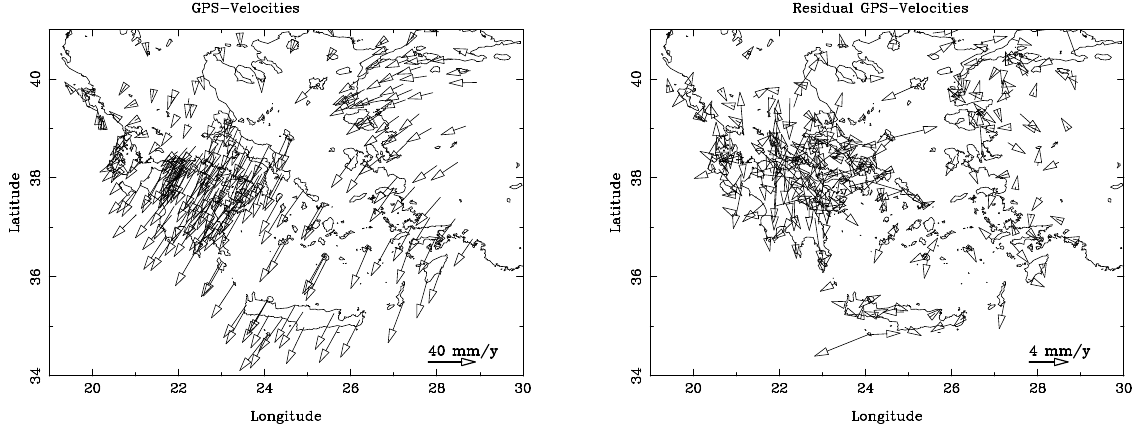
Fig. 12. Observed GPS velocities of Floyd et al. (2010) (left) and residuals between observed and interpolated continuous velocity field (right).